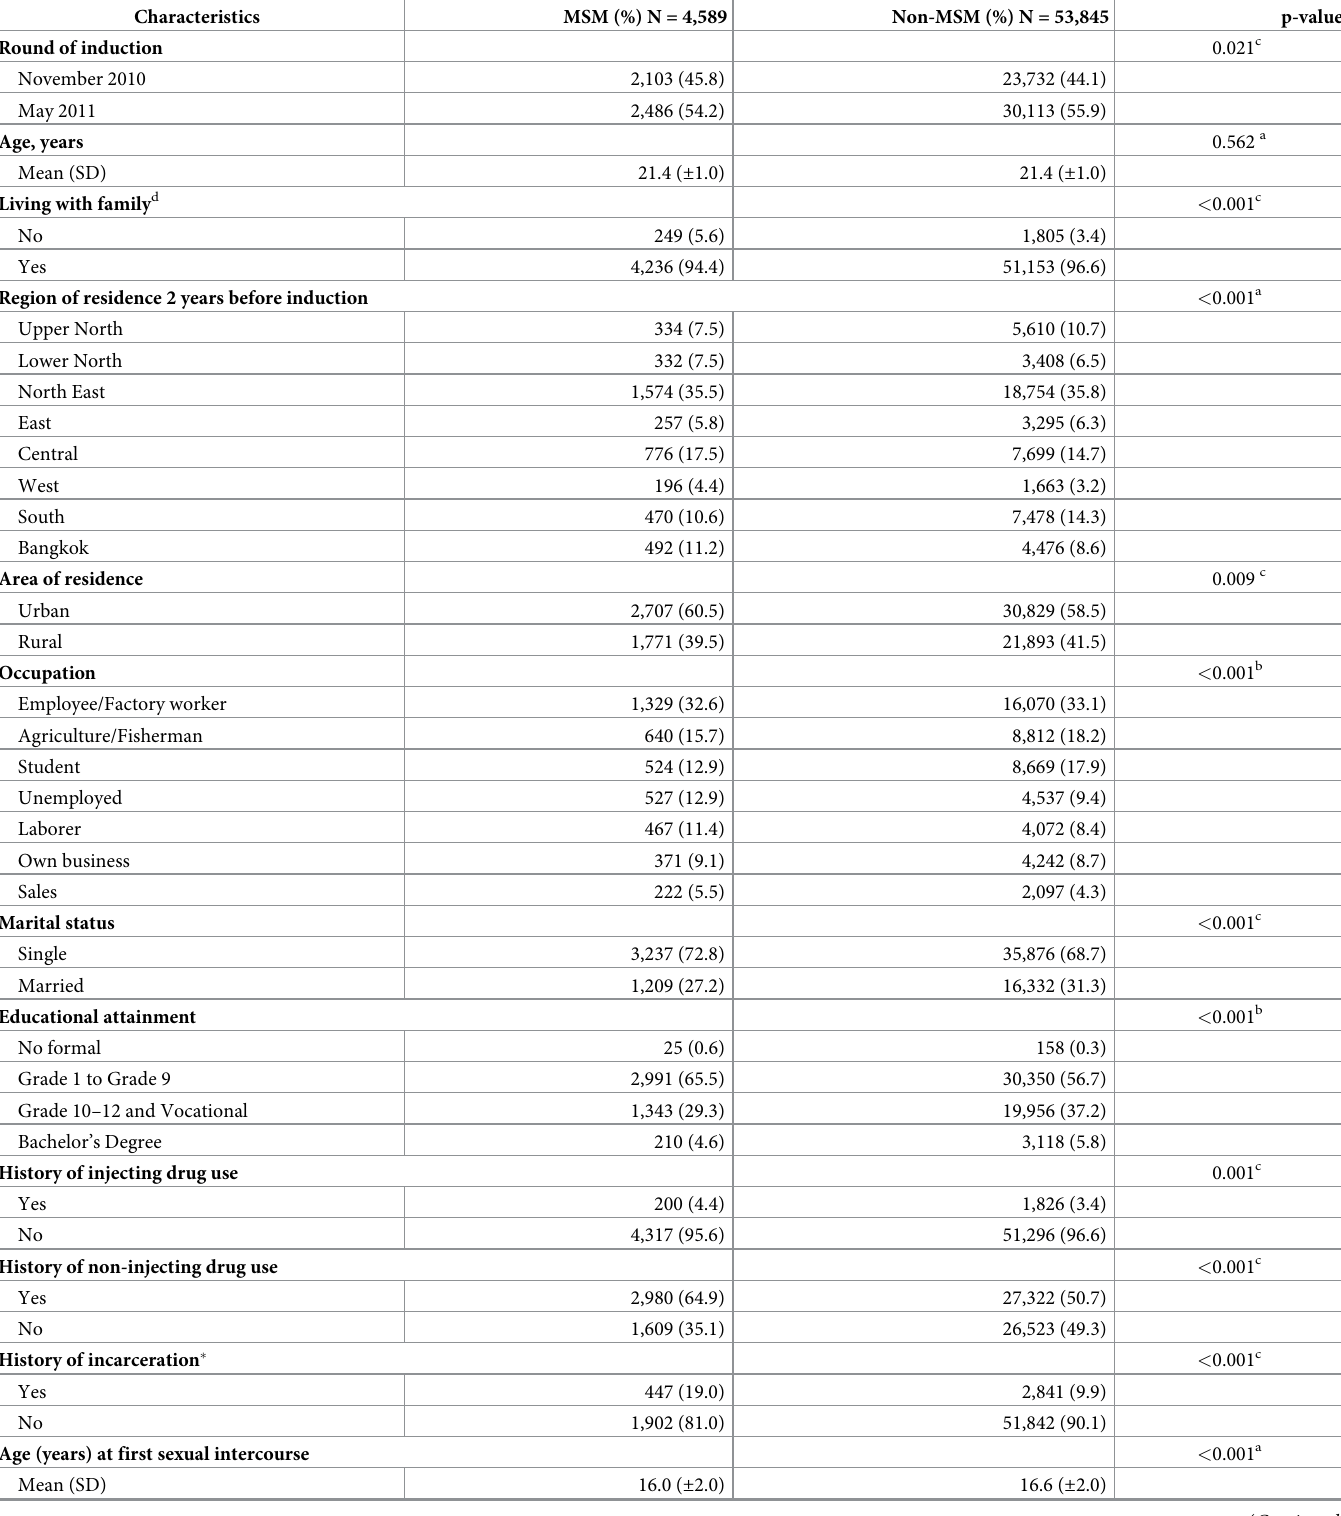
Table 3. Demographic and behavioral profile of identified men who have sex with men and non-MSM among the participants before induction.